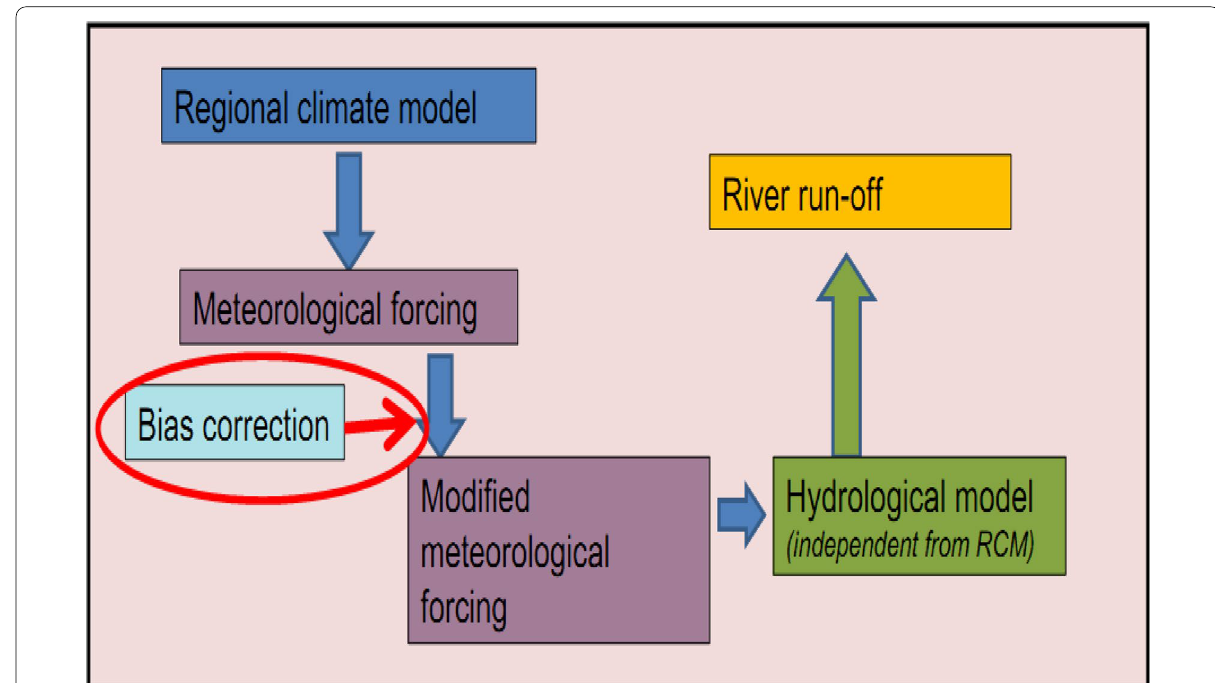
Fig. 2 Conceptual framework for bias